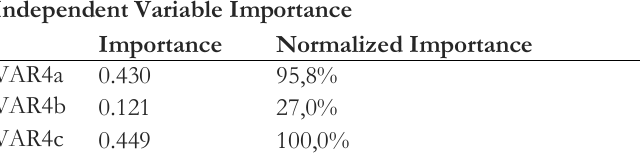
Table 9. Independent variable importance for classical item 4 in terms of neutrosophic items.